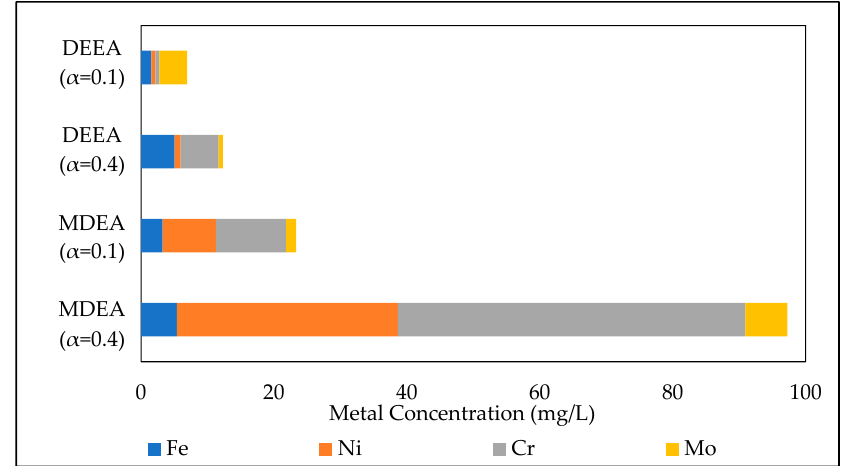
Figure 15. Metal concentrations of 30 wt.% aqueous MDEA and DEEA solutions after week five at various CO 2 loadings.